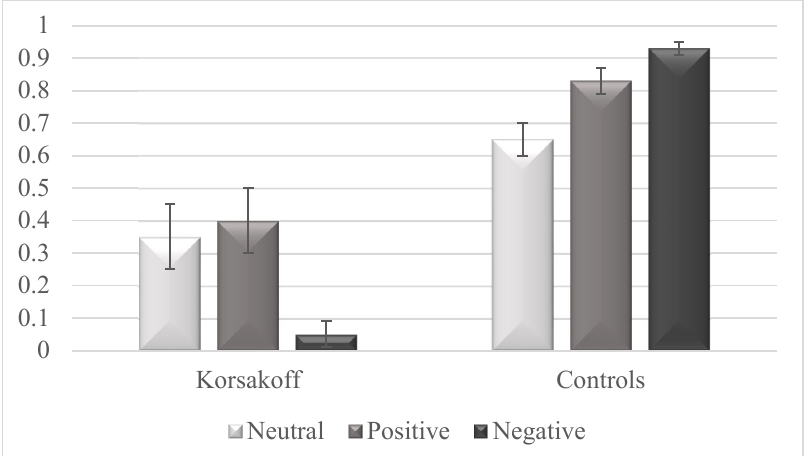
Figure 1. Destination memory performance of patients with Korsakoff’s syndrome and control participants when telling facts to neutral, positive, and negative faces. Scores refer to proportion of hits minus proportion of false recognitions. Error bars represent intervals of 95% within ‐ subjects confidence.